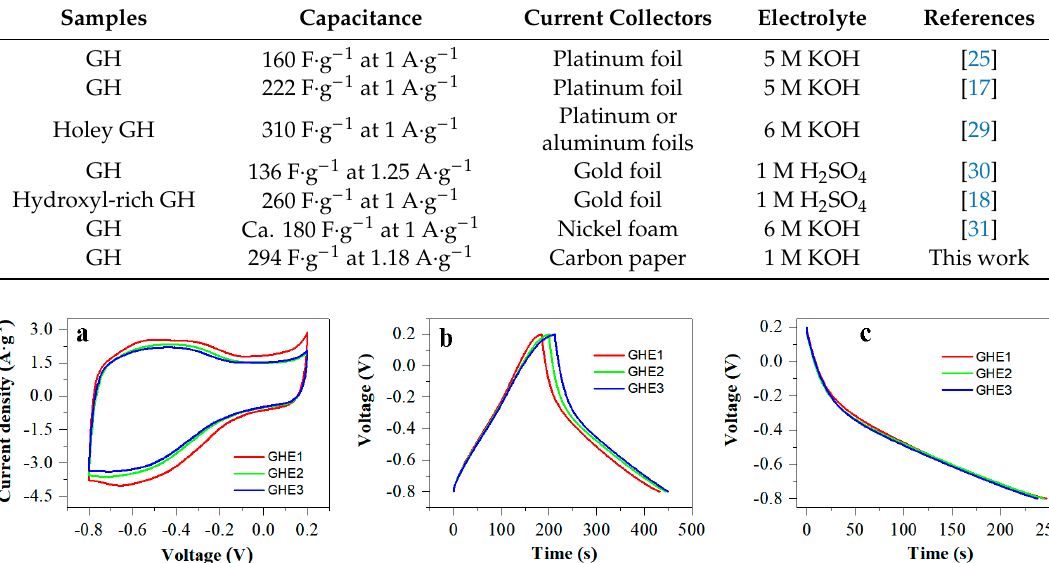
Figure 5. CV plots ( a ), GCD curves ( b ) and galvanostatic discharge (GD) curves ( c ) for supercapacitors based on GHE1, GHE2, and GHE3, respectively.